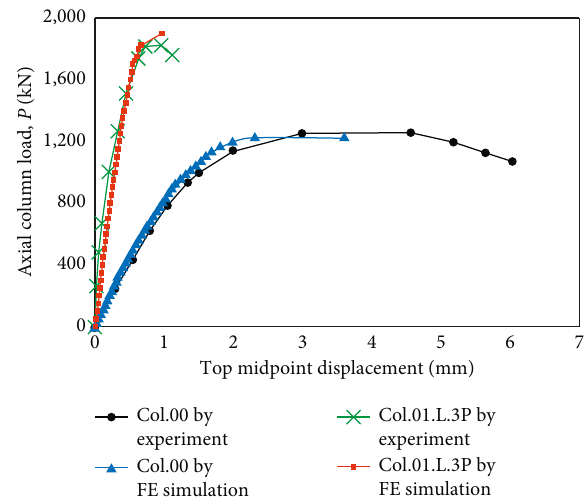
Figure 3: Curves showing displacement of load gained from both experimental outcomes Belal et al. [3] and FE results.